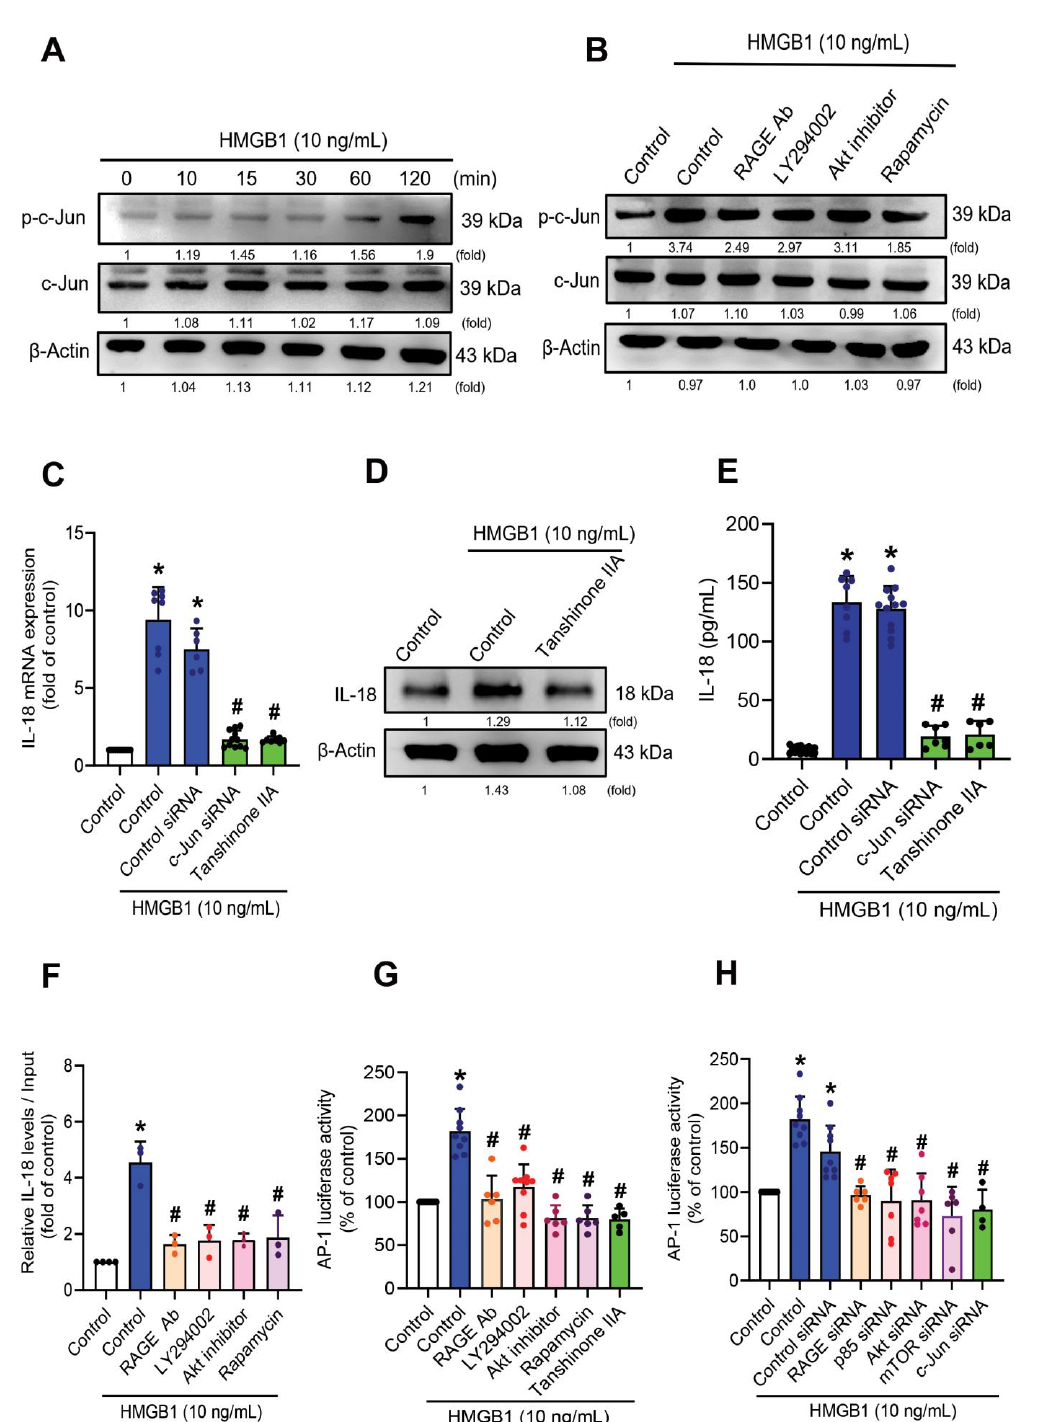
Figure 5. c-Jun is involved in HMGB1-induced IL-18 production via the RAGE/p85/Akt/mTOR signaling pathway. ( A ) C2C12 cells were treated with HMGB1 (10 ng/mL). Cell lysate was collected at the indicated time points and subjected to immunoblotting to detect total protein levels and phos- phorylation levels of the indicated proteins. ( B ) C2C12 cells were pretreated with RAGE neutralizing antibody (5 µ g/mL), LY294002 (10 µ M), Akt inhibitor (10 µ M), or rapamycin for 30 min, then with HMGB1 (10 ng/mL) for the next 2 h, before detecting protein expression and phosphorylation levels of the indicated proteins. ( C – E ) The C2C12 cells were transfected with control siRNA or c-Jun siRNA, or pretreated with tanshinone IIA (10 µ M), followed HMGB1 (10 ng/mL) treatment for 2 h. IL-18 mRNA expression, protein expression and levels of IL-18 secretion were detected by ( C )